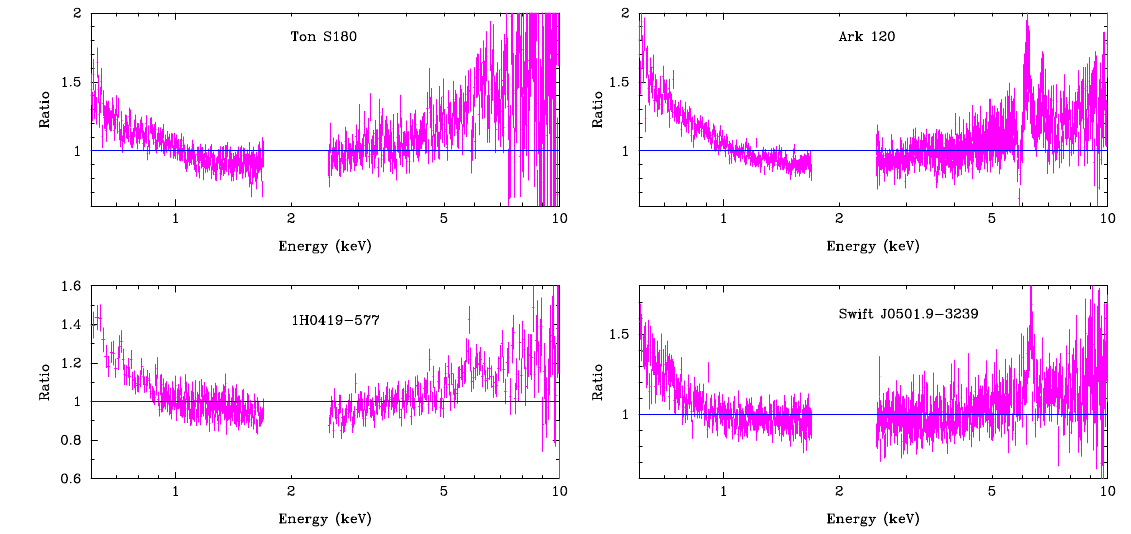
Fig. 3 Data-to-best-fit-model ratios for the four sources of our study when the spectra are described by a power-law component